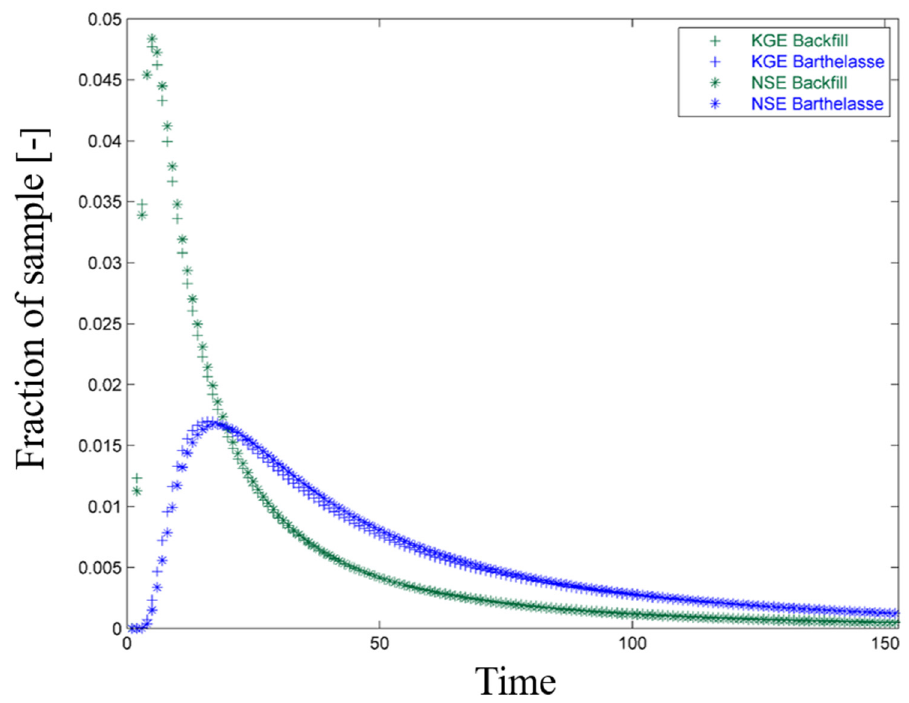
Figure 9. Distribution of transit times within the backfill and Barthelasse on an annual scale.